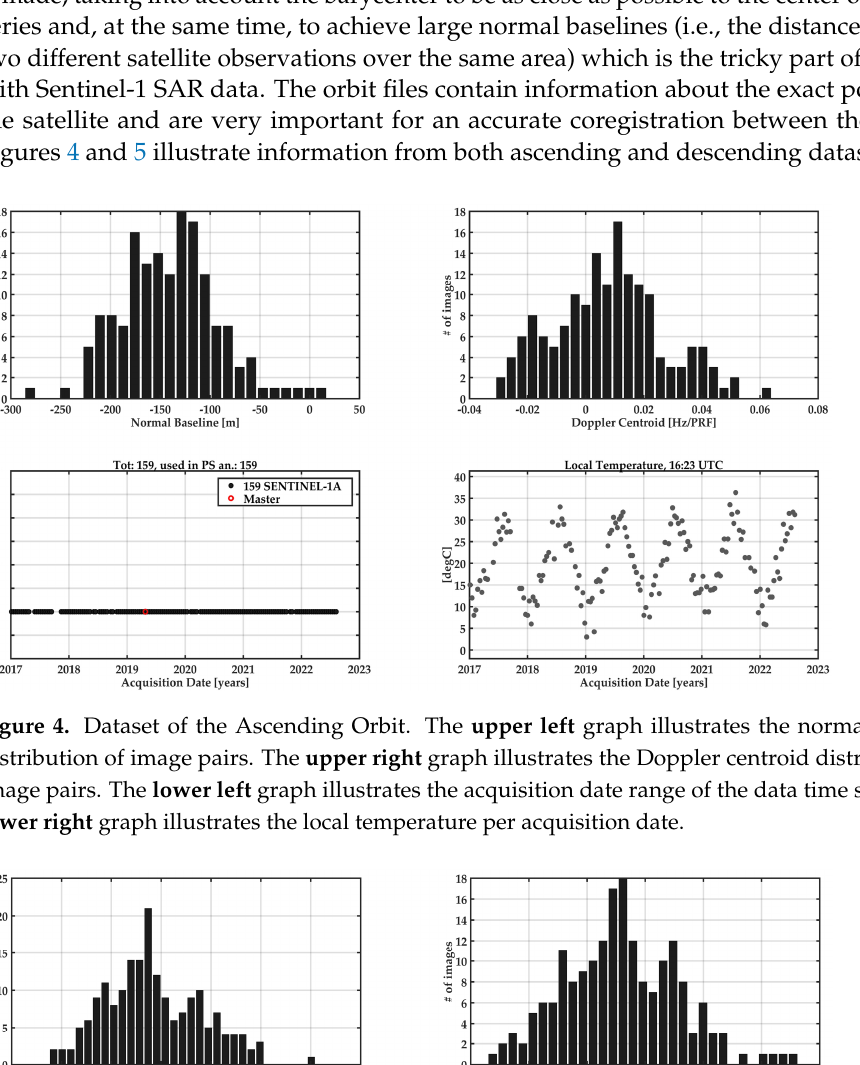
Figure 3. Flowchart of the proposed method.